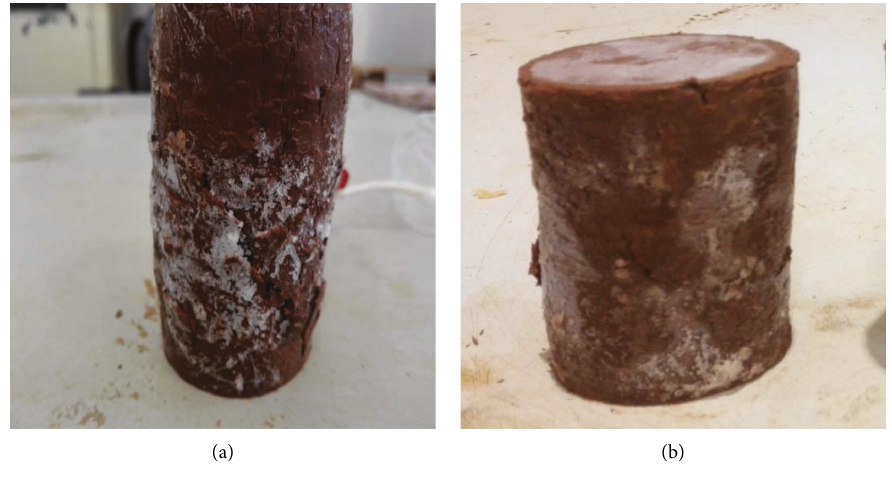
Figure 6: Two damage forms of frozen red